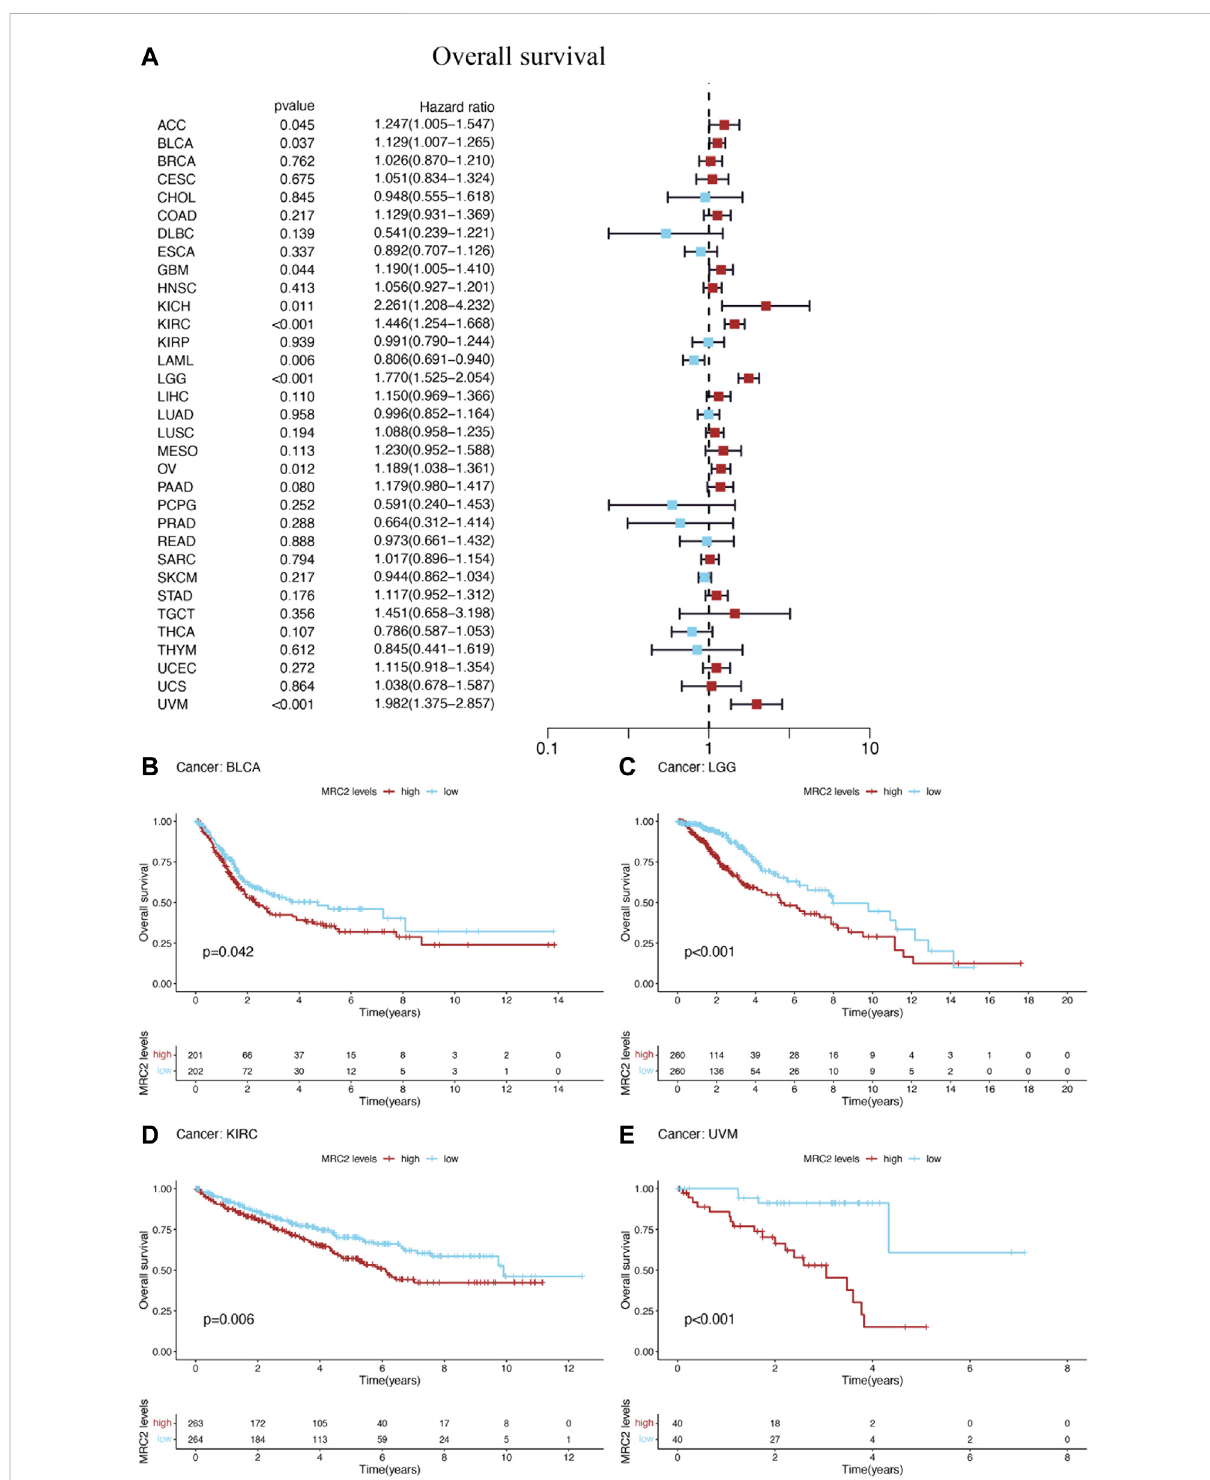
FIGURE 2 The forest plots of univariate Cox regression analyses for overall survival (OS). (A) The highlight items mean that MRC2 expression was signi fi cantlycorrelatedwithprognosisinthesecancertypes( p < 0.05).Itemswithhazardratiogreaterthan1indicatedthattheMRC2expressionwas a promoting factor of death. The Kaplan – Meier curves were plotted to visualize the OS of MRC2 expression levels in different cancers (B – E) .